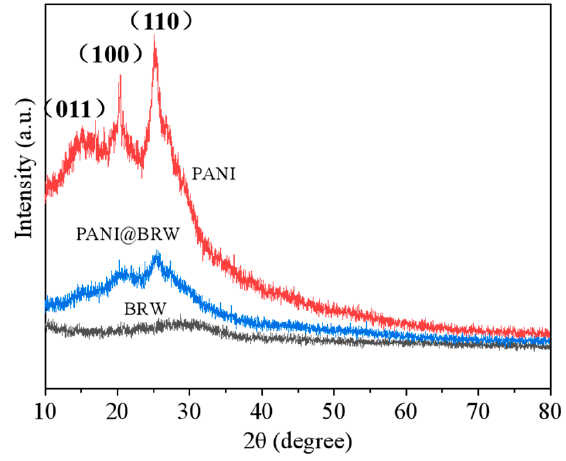
Figure 5. X-ray diffraction (XRD) patterns of BRW, PANI, and PANI@BRW.